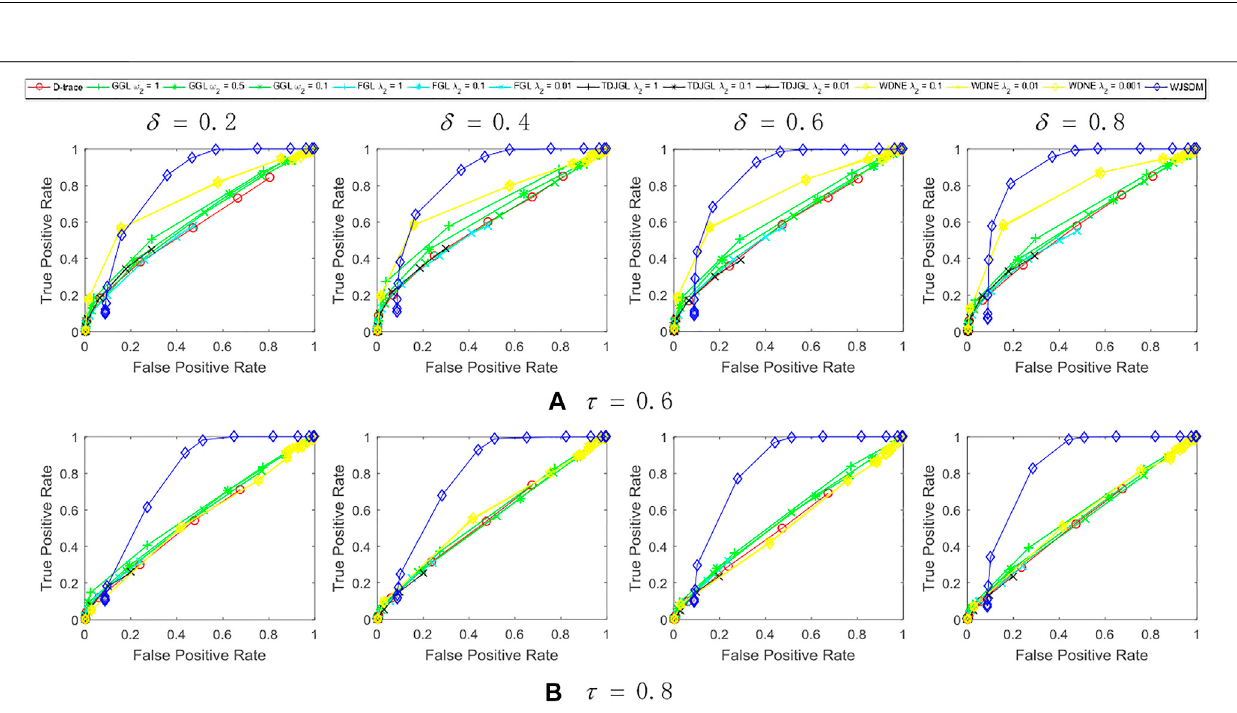
Frontiers in Genetics |